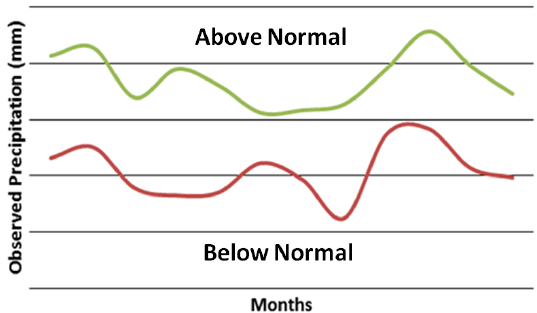
Fig. 2. Boundaries of the three categories of monthly rainfall – above normal (above the green line), below normal (below the red line) and normal (the line between green and red) – for the five homogeneous regions: Region 1 (a) , Region 2 (b) , Region 3 (c) , Region 4 (d) , Region 5 (e) , Mean Basin (h)